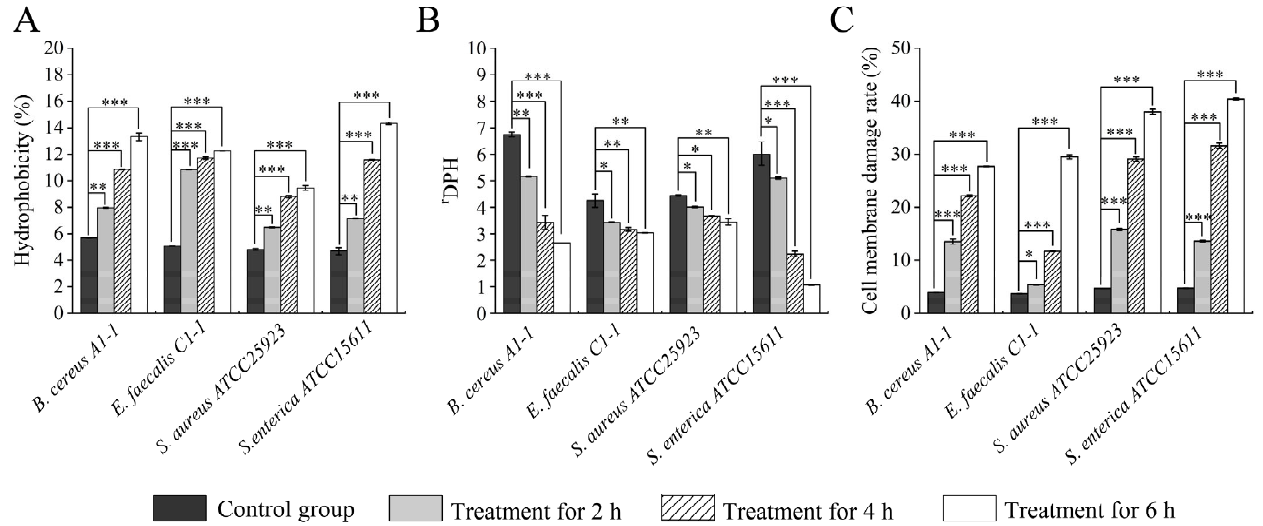
Figure 2. Effects of Fragment 1 from C. communis Linn on cell surface hydrophobicity, membrane fluidity and damage of the four bacterial strains. ( A – C ) cell surface hydrophobicity, cell membrane fluidity, cell membrane damage, respectively. Results presented as means ± S.D. of three repetitions. *: p < 0.05; **: p < 0.01; and ***: p < 0.001.